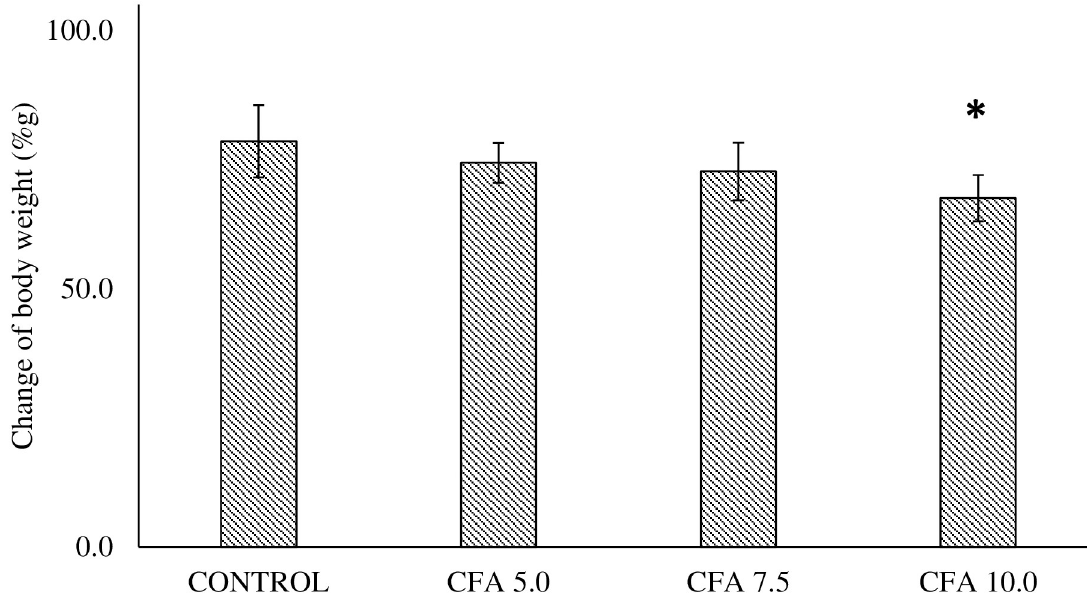
Fig 1. Percentage of body weight changes in CFA treatment groups (n = 6). The data are presented as mean ± standard error of the mean (SEM). � p < 0.05 statistical comparison between the group receiving CFA injection at 10 mg/mL to the control group.